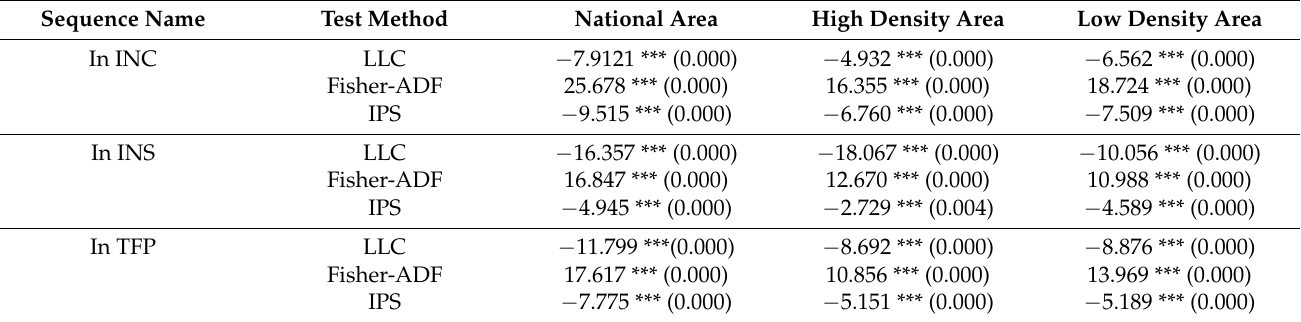
Table 2. Unit root test results.